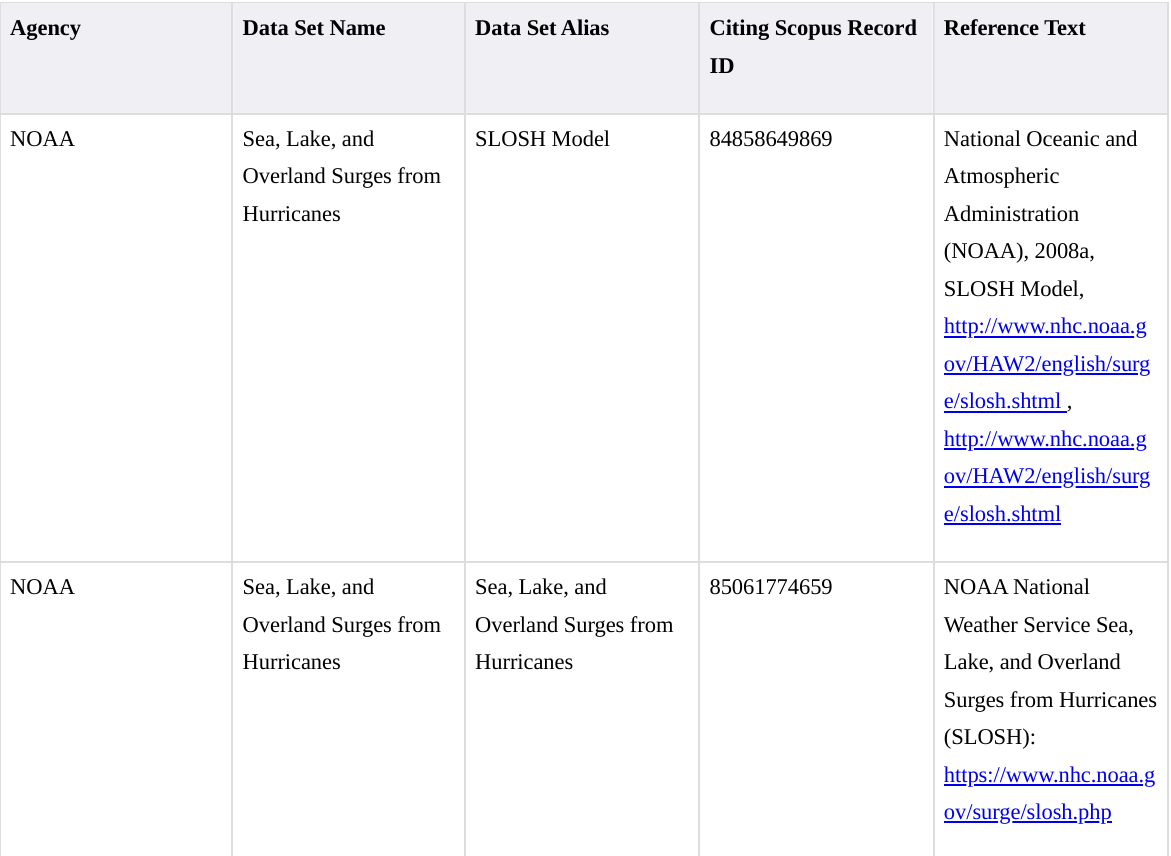
Table A1. Example of search